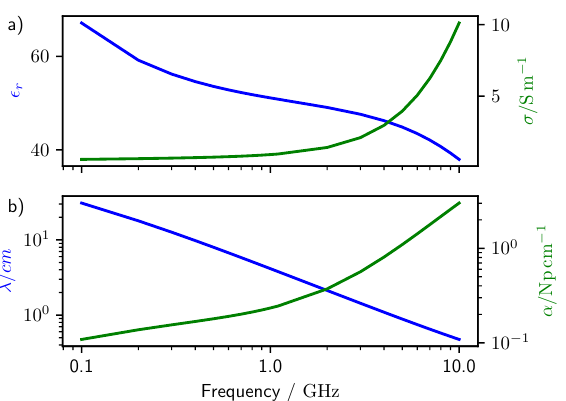
Figure 1. Dielectric properties of lung tissue taken from the Tissue Properties Database [15]. ( a ) rela- tive dielectric permittivity (cid:101) r and conductance σ of lung tissue. ( b ) Wavelength λ and attenuation α of a plane wave traveling through lung tissue (calculated from a ).